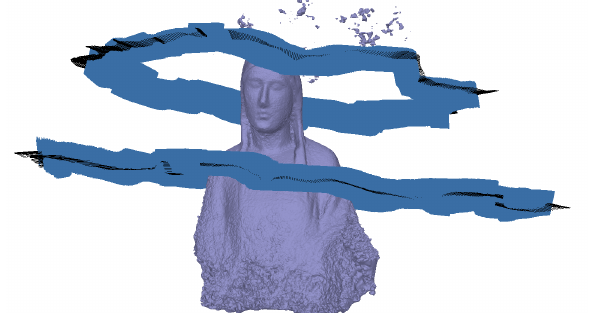
Figure 6: The two separated video trajectories and the small ”fly- ing drops” around the